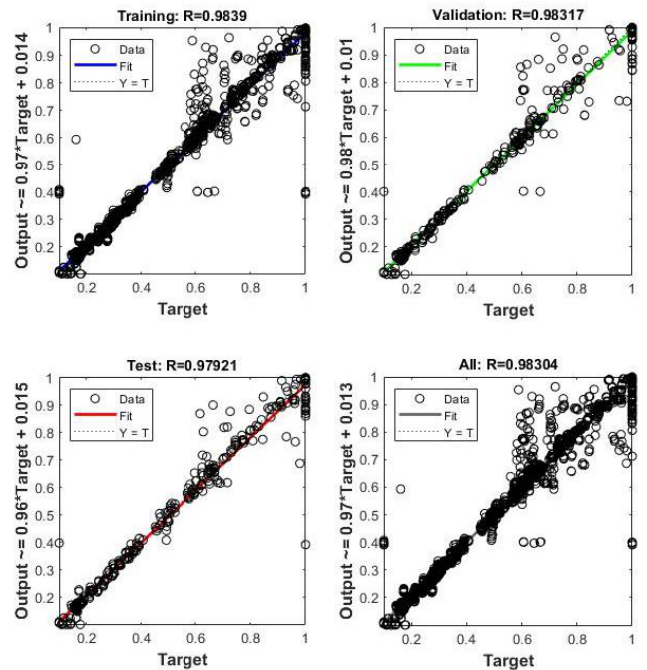
Figure 7. R values of the Training, Validation, and Test of ANN for base shear output.